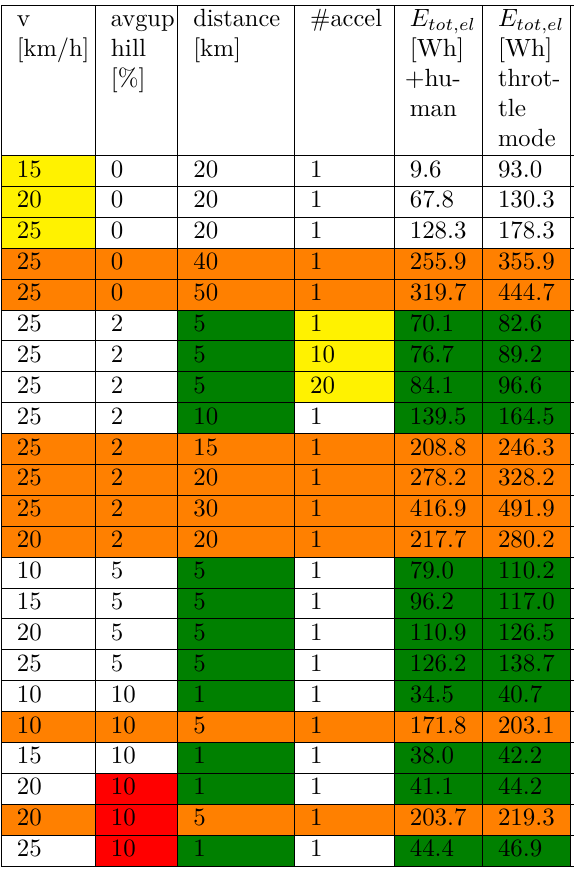
Table 1. Estimated energy consumption within 23 different